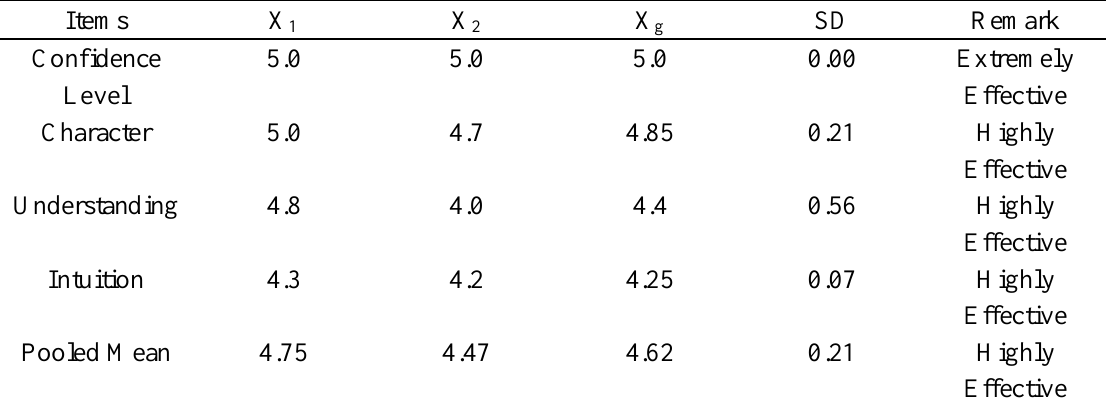
Table 1: Mean rating of early childhood education as a panacea to family restiveness? Items